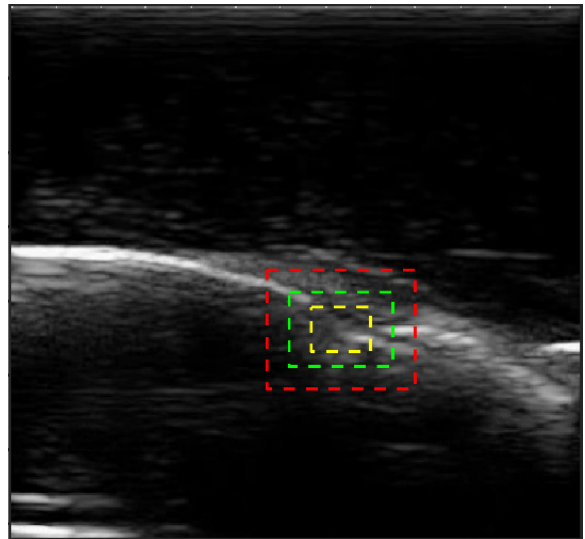
Figure 3. An example shows three different bounding box sizes: SBB in yellow, MBB in green, and LBB in red in the same image.